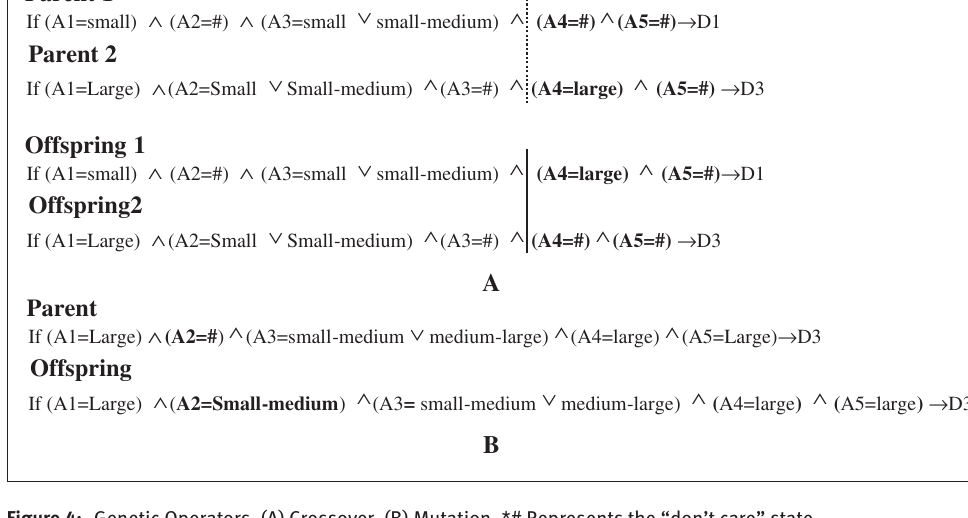
Figure 4: Genetic Operators. (A) Crossover. (B) Mutation. *# Represents the “don’t care”